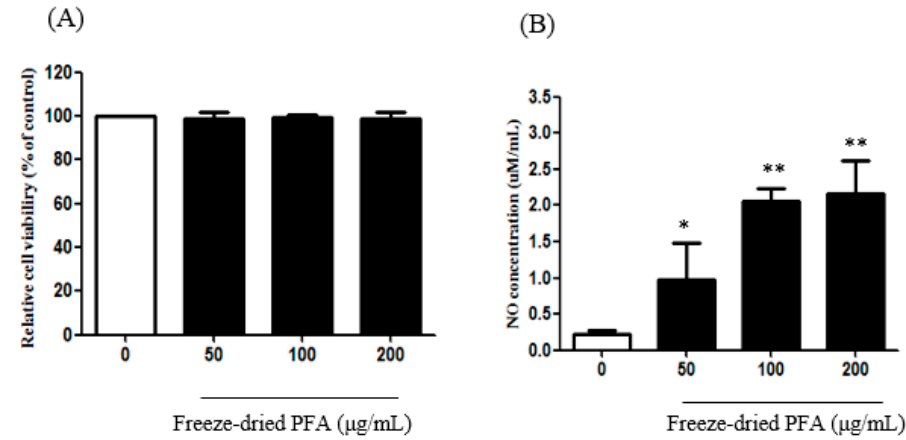
Figure 3. Effect of freeze-dried Perilla frutescens var. acuta (PFA) on ( A ) cell viability and ( B ) nitric oxide (NO) in rat ciliary smooth muscle cells. rCSMCs were treated with 50 µg/mL to 200 µg/mL of the freeze-dried PFA for 24 h. Cytotoxicity was estimated by the MTT assay and NO was quantified using the Griess agent. The data are represented as mean ± SD. * p < 0.05 and ** p < 0.01.